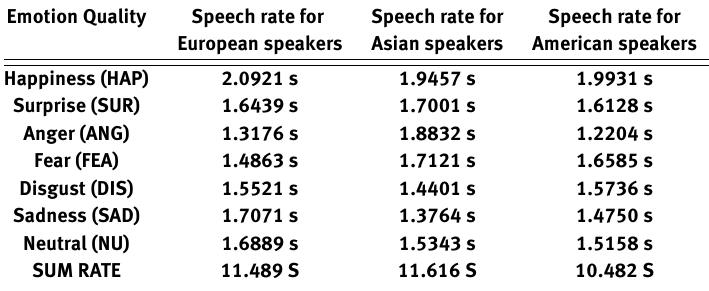
Table 1. Speech rate of basic emotions (average of the 15 experimental tests) for European, Asian and American.